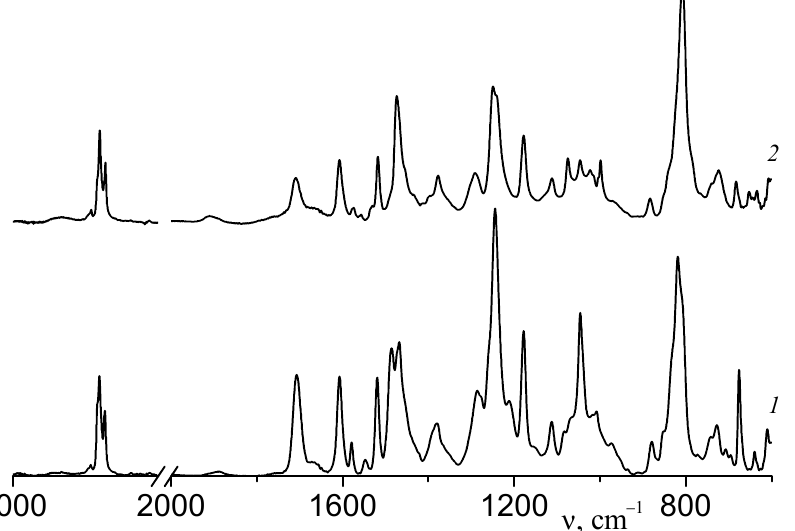
Figure 8. FTIR spectra of the products obtained after heating BVK (1) and QVK (2) in the DSC cell from − 40 to 300 °C with a heating rate of 10 K·min − 1 .